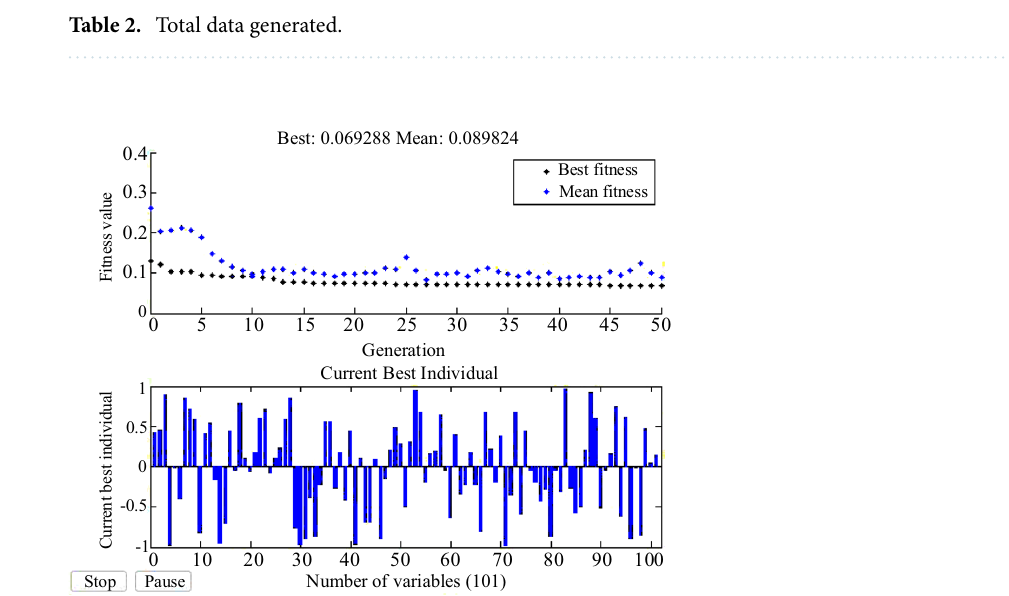
Figure 23. ANN training process by GA